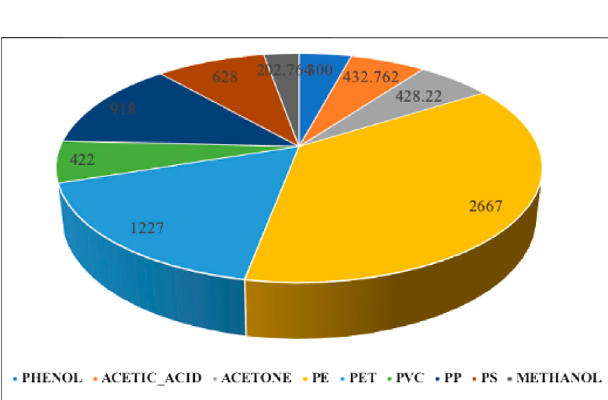
FIGURE 4 | Chemicals and plastics demand (GWh) of Switzerland,